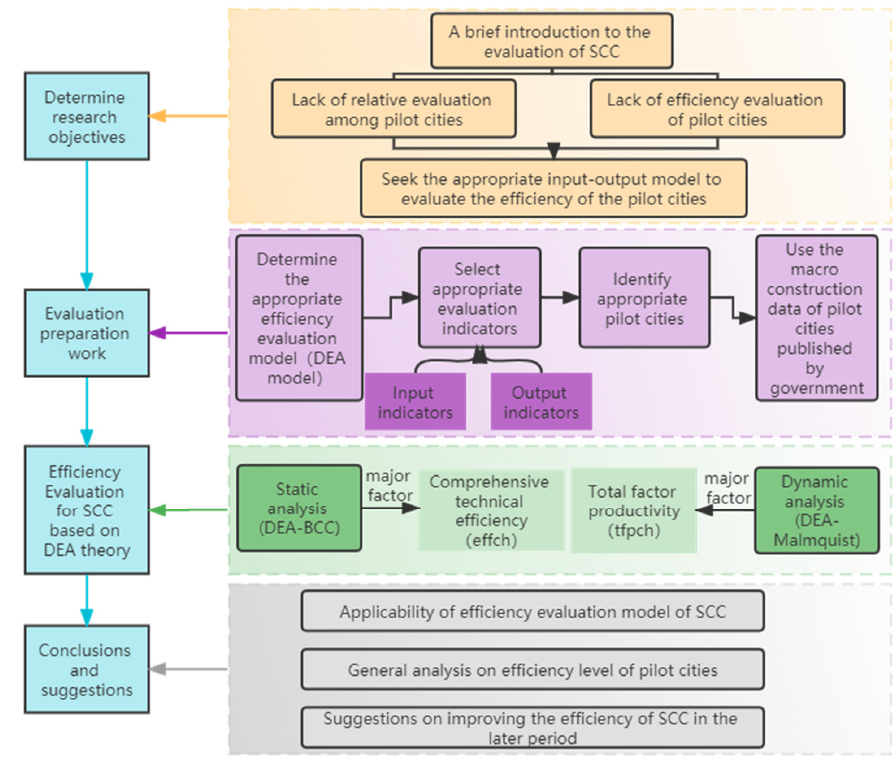
Figure 1. The efficiency evaluation framework of SCC pilots.